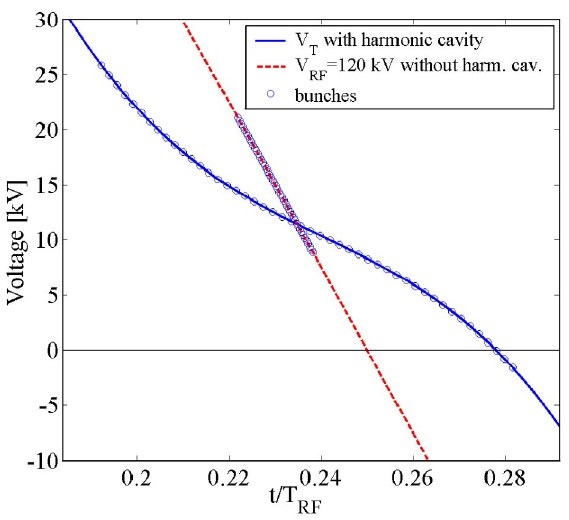
FIG. 6. (Color) Bunch position over the rf voltage.